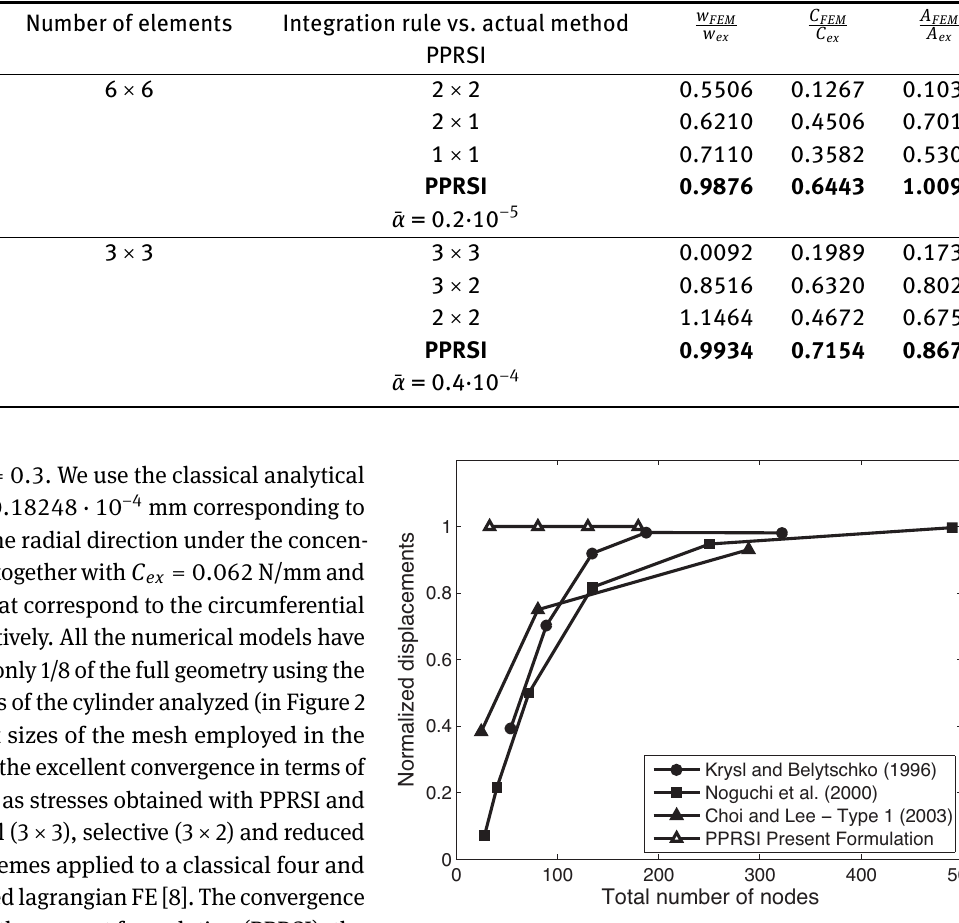
the ¯ α comes exactly within the range of values numerically